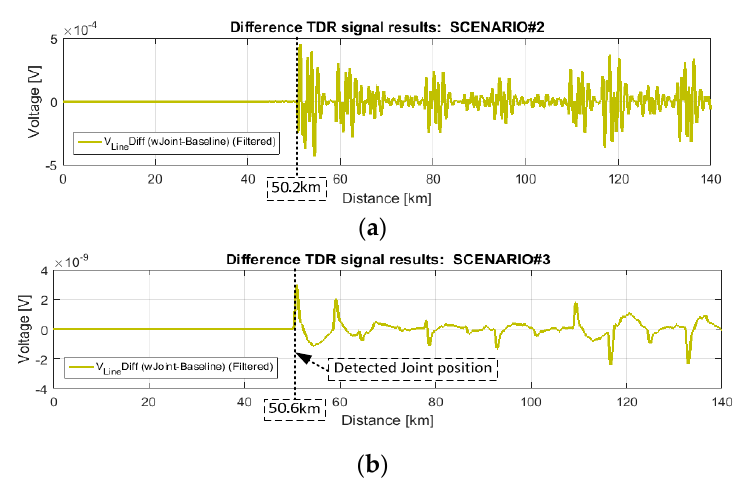
Figure 15. Extracted difference TDR responses when using the injection/measurement connections of: ( a ) Scenario#2, ( b ) Scenario#3.